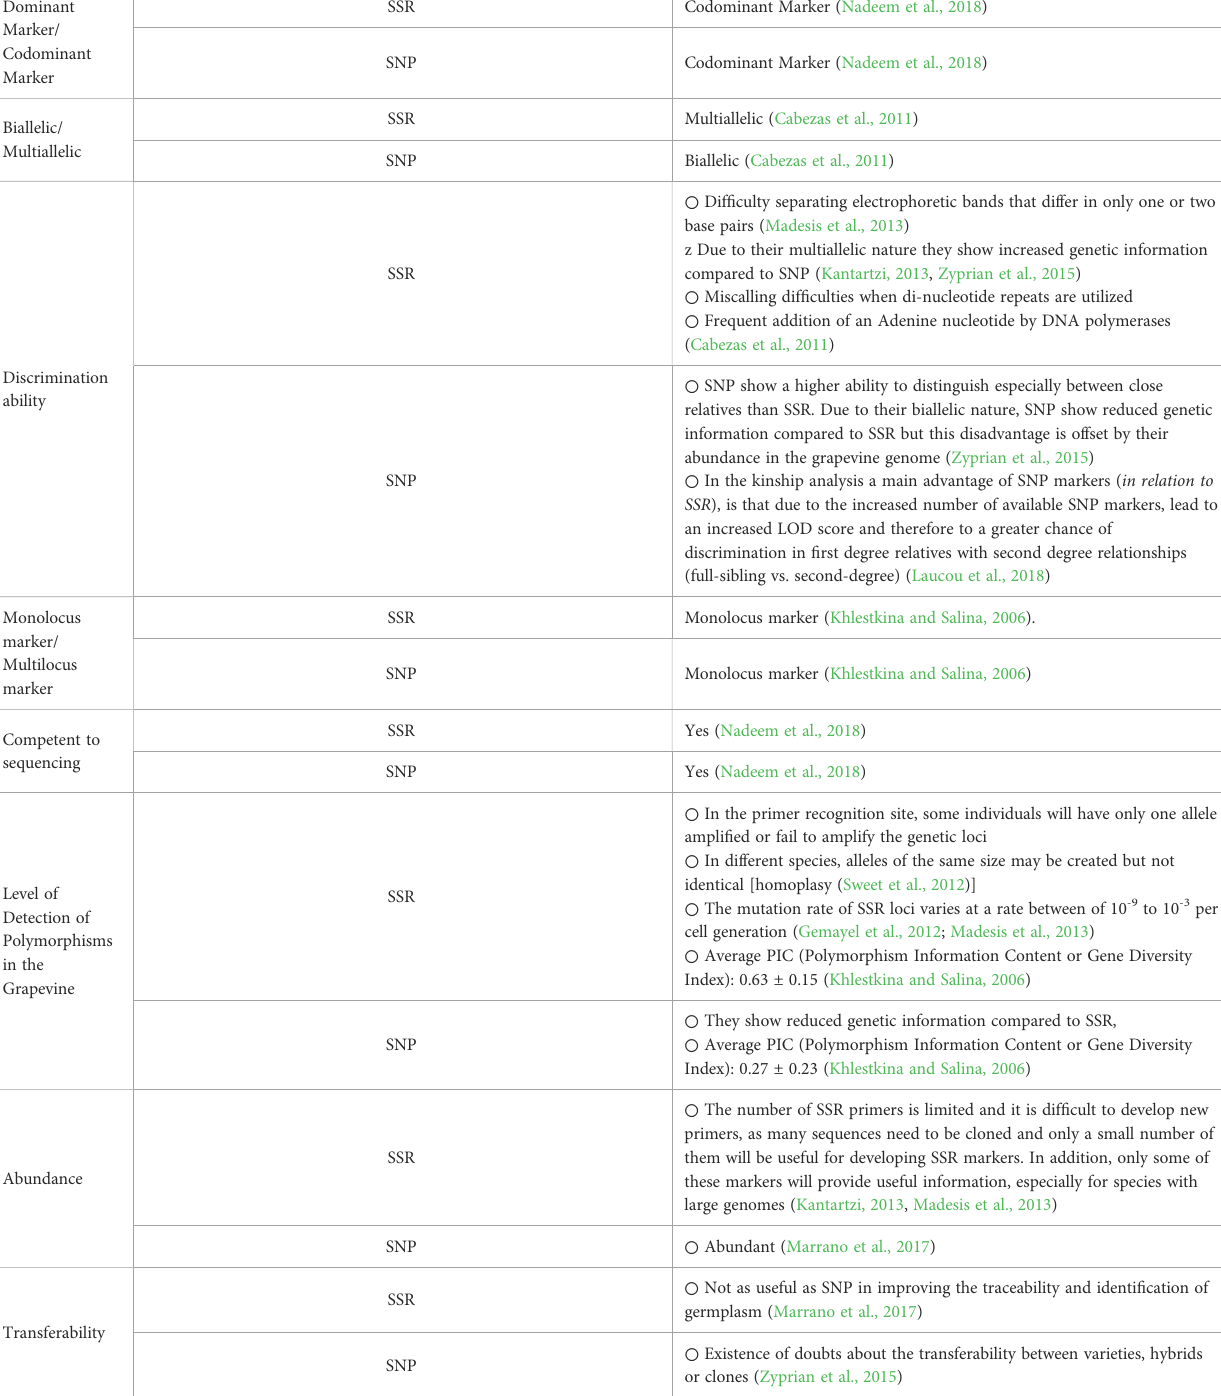
TABLE 1 Basic features of SSR and SNP molecular markers used for the identi fi cation of Vitis